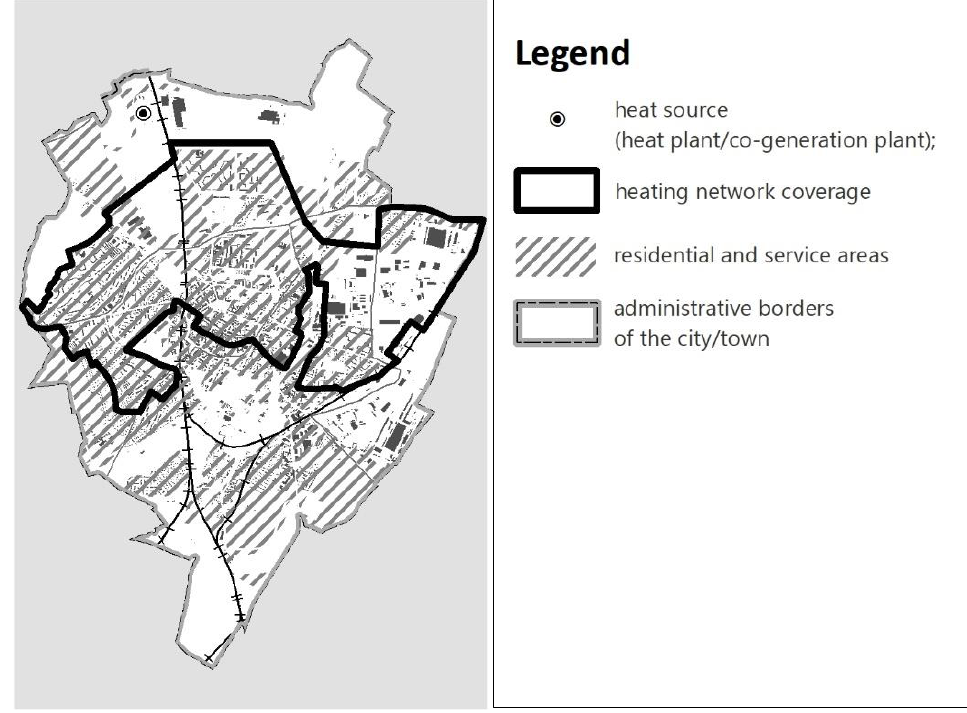
Figure 6. Areas intended for housing and service development, and the range of the district heating network in Świdnica. * HSAs—housing and service areas.